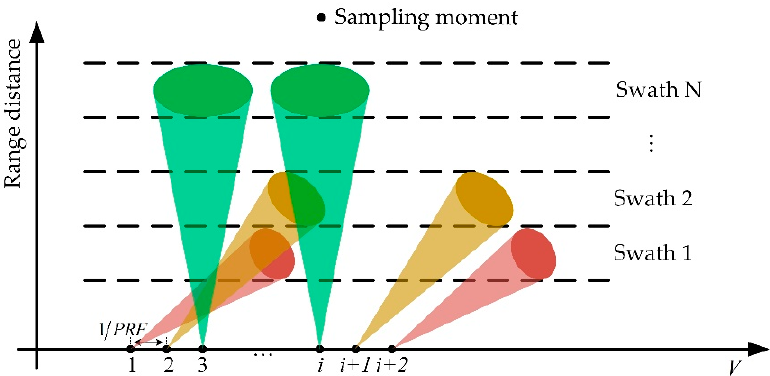
Figure 2. Pulse assignment diagram of the new scanning method, where each pulse is randomly assigned to one of the subswaths on the ground and different subswaths have different squint angles.